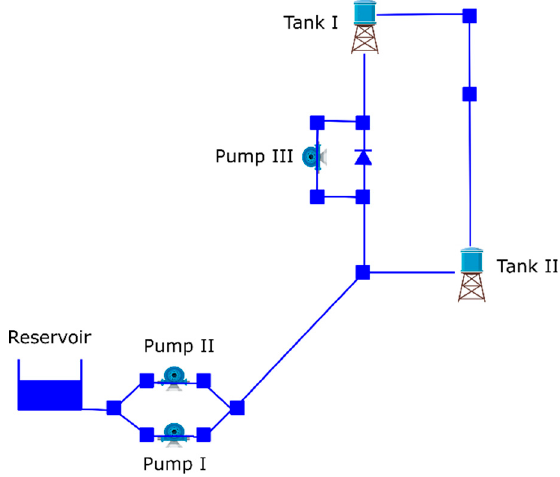
Figure 2. Van Zyl network.